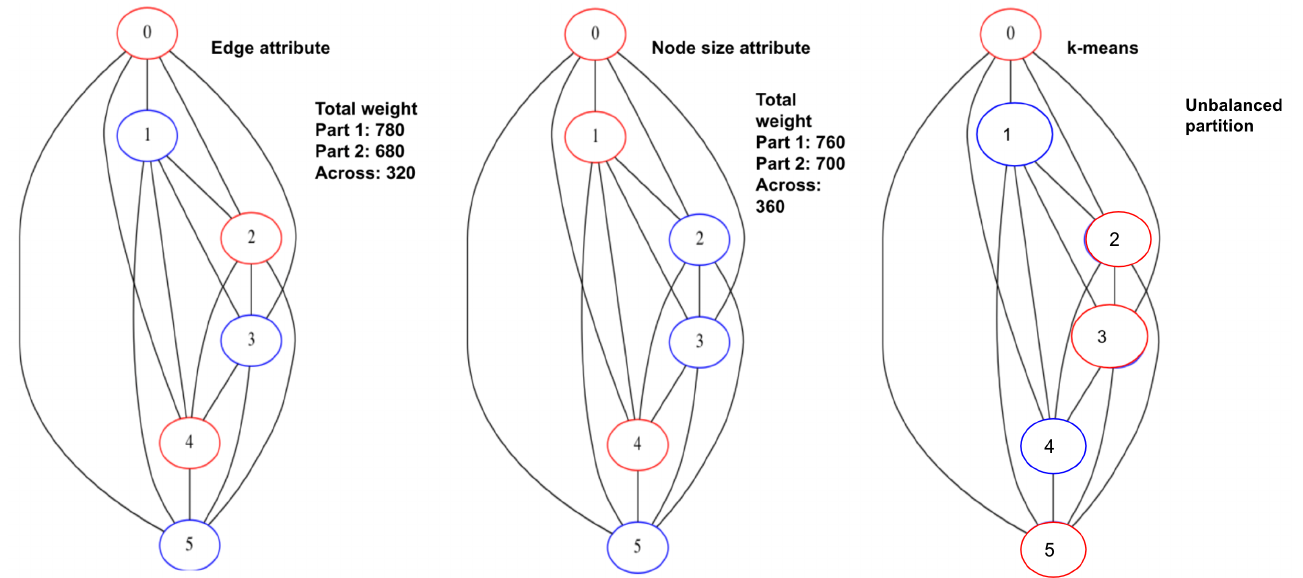
Figure 5. The partitioned graph after using the proposed partitioning methods (left to right): (1) Edge size attribute, (2) Node size attribute, (3) K-means method. Red-colored vertices belong to Partition 1 and blue-colored vertices belong to Partition 2.